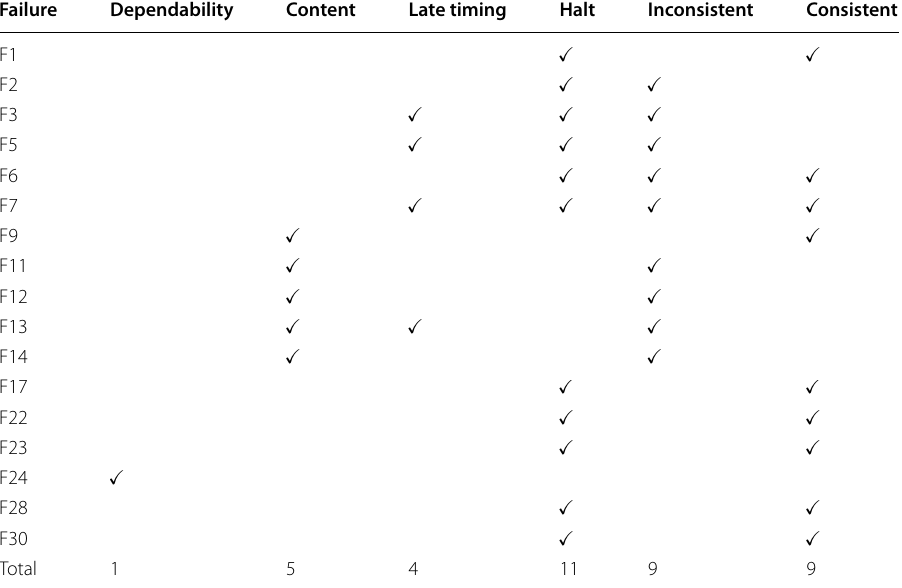
Table 3 RQ3 (Types of